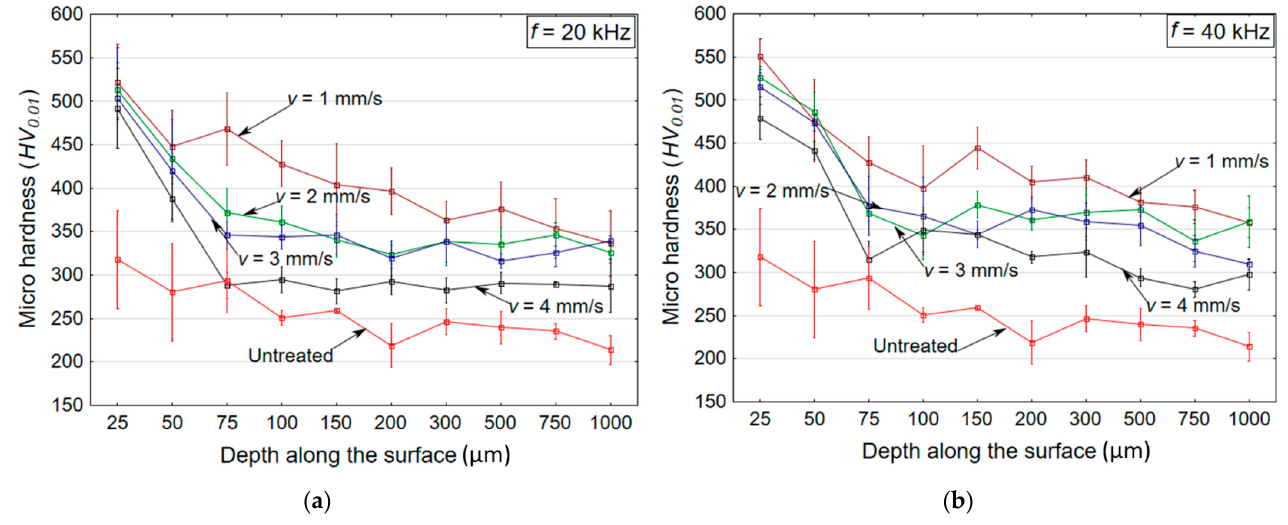
Figure 5. Variation in the microhardness along the depth at ( a ) f = 20 kHz and ( b ) f = 40 kHz.